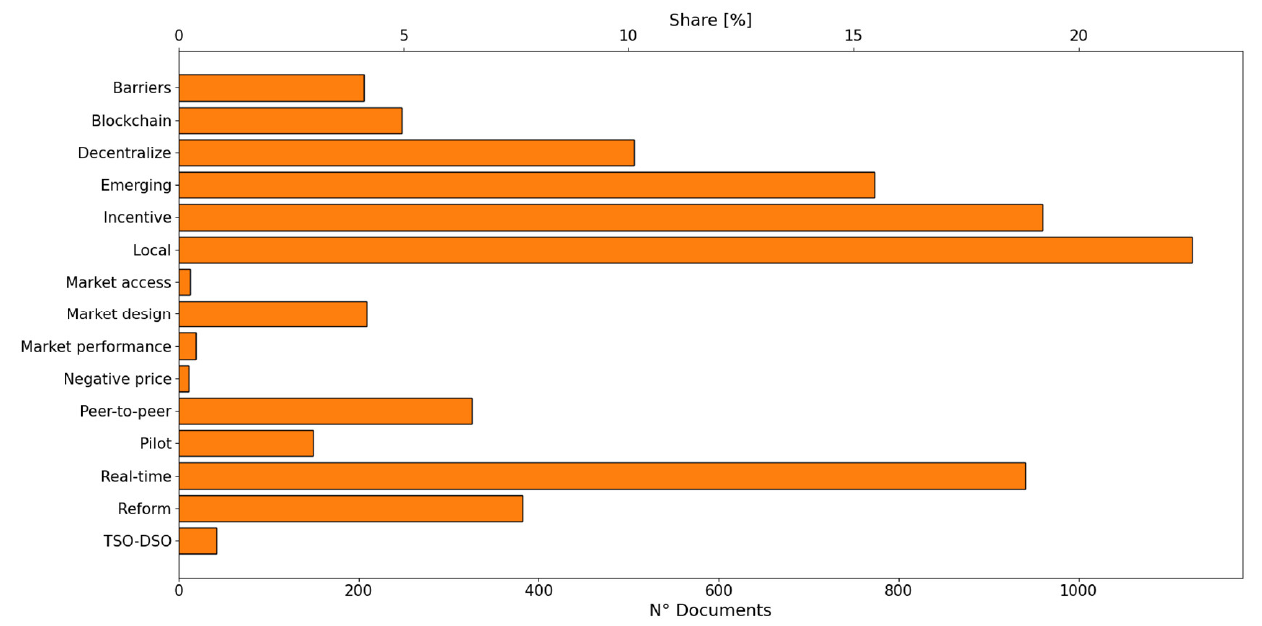
Figure 2. Number of documents including keywords related to the topic of interest (reformation of market structure to enable the access of DERs), both in absolute terms and percentage with respect to the total number of documents.